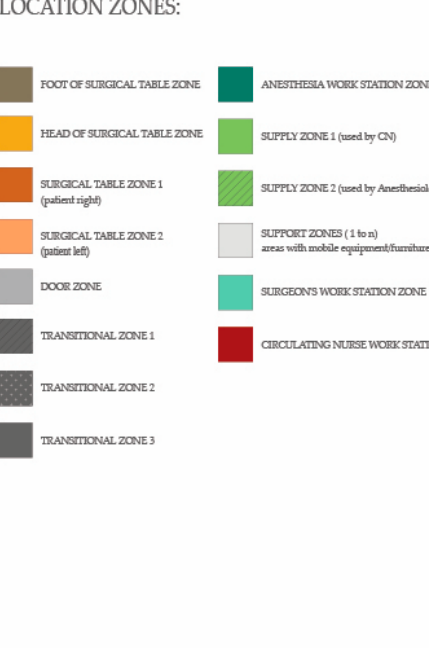
Figure 3. Floor plans of the four ORs observed with zones demarcated (refer to Figure 2 for legend). All floor plans are shown with surgical tables in orientation B. 2.1. Surgical Table Orientation Four different table orientations were identified: (A) the surgical table angled in the room with the head of the table in the anesthesia zone (orientation A), (B) parallel to the long or short walls (depending on shape of room) of the room with the head of the surgical table in the anesthesia zone (orientation B), (C) parallel to the long or short walls of the room (depending on room shape) with the anesthesia zone perpendicular to the head of the patient (orientation C) or (D) angled in the room with the anesthesia zone adjacent to the head of the surgical table (orientation D) (Figure 4). The zone boundaries and zone locations (especially head and foot of surgical table) changed based on table orientation and thus, the specific plans associated with each table orientation were used as reference